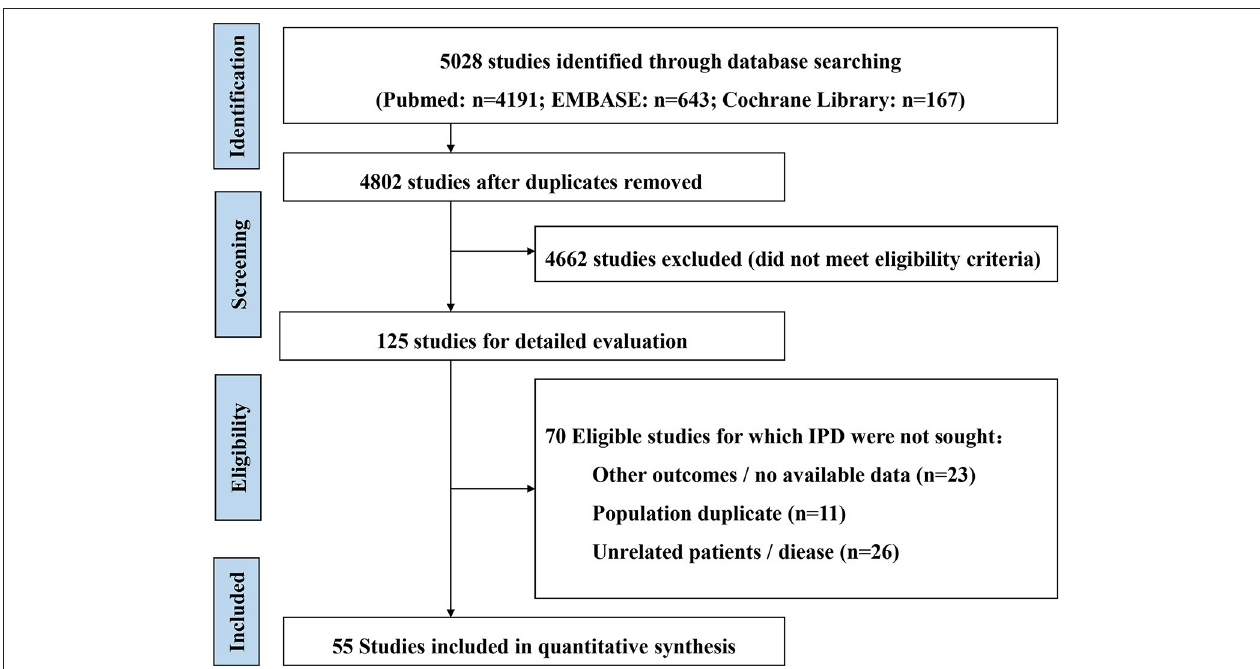
FIGURE 1 | Flow chat of study